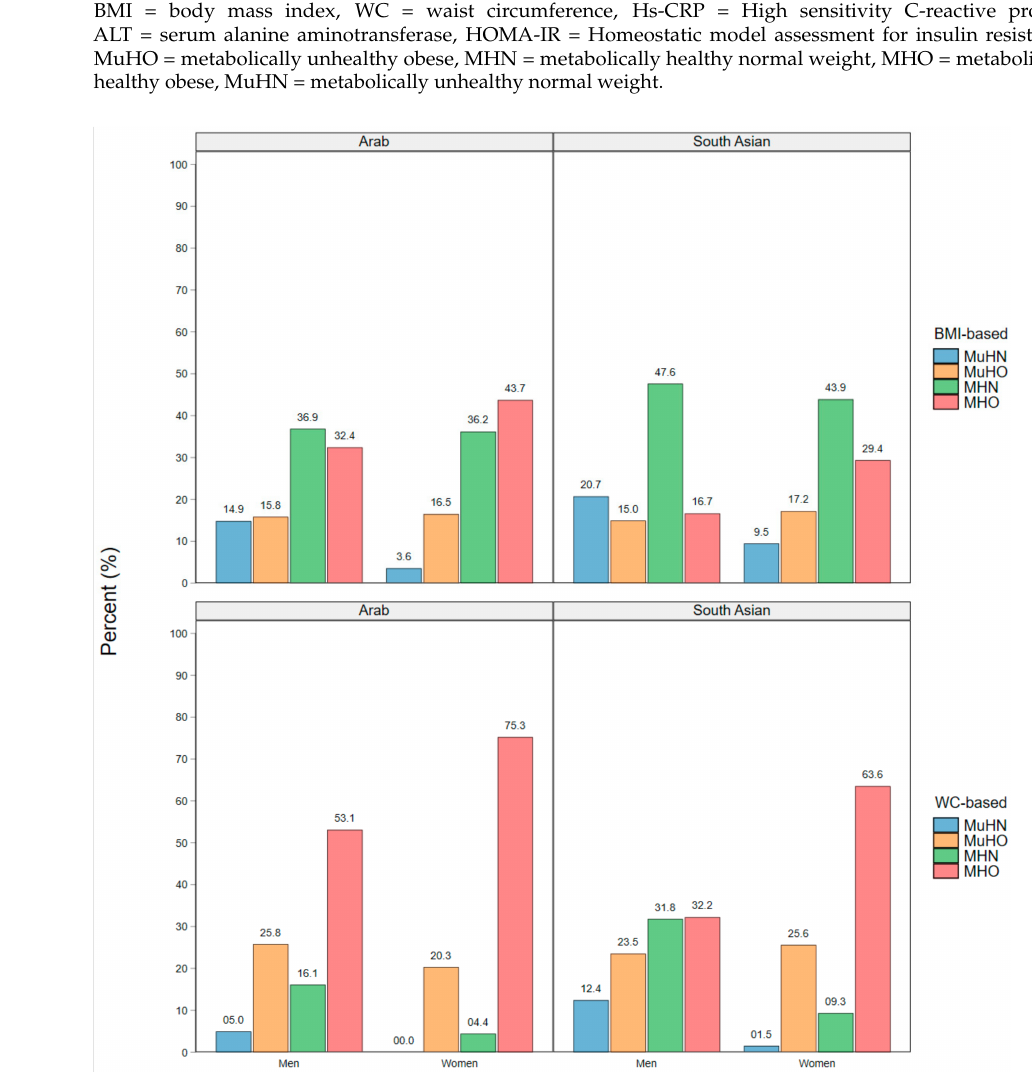
Figure 2. Prevalence of the BMI- and WC-defined metabolically healthy and unhealthy obese phenotypes by gender and ethnic